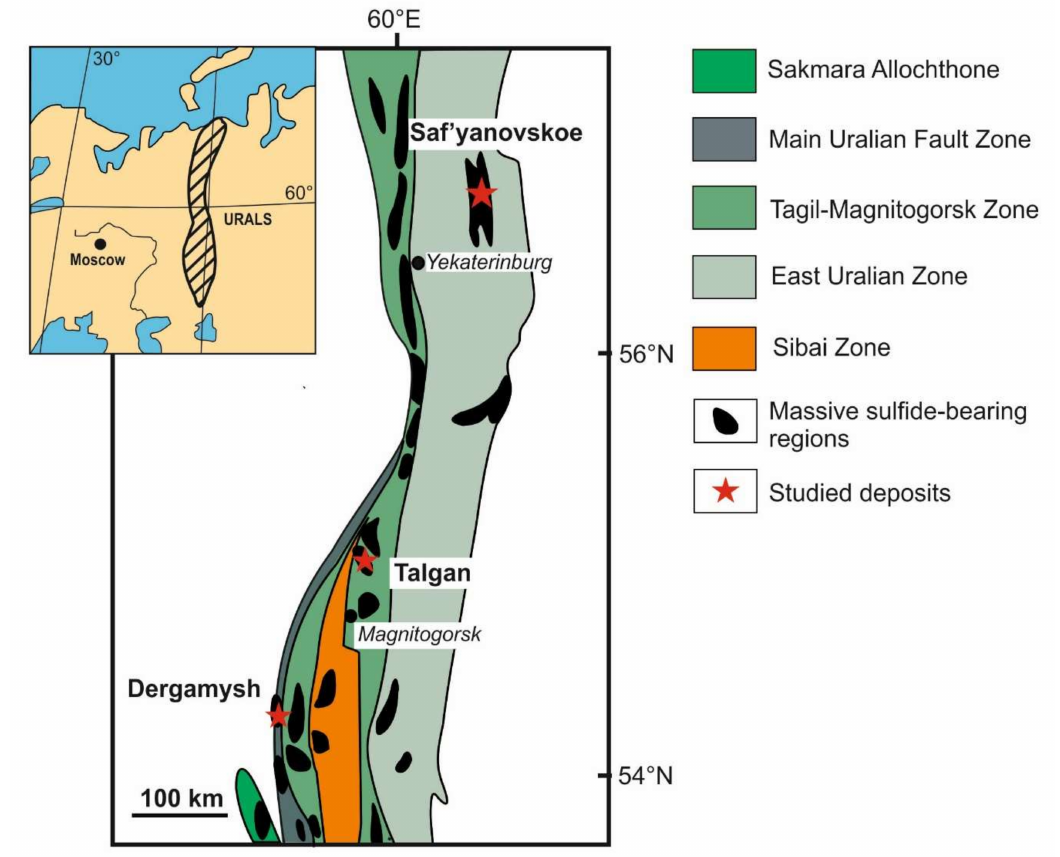
Figure 1. Geotectonic structure of the Urals and position of massive sulfide regions and studied deposits simplified after